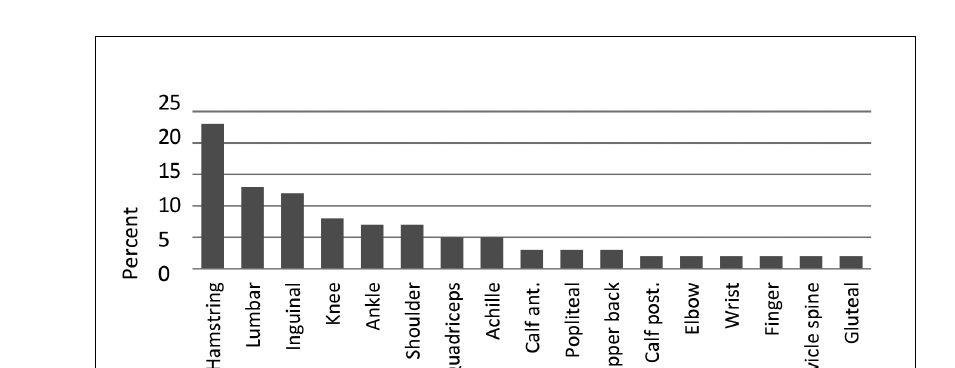
Figure. 1. All injuries